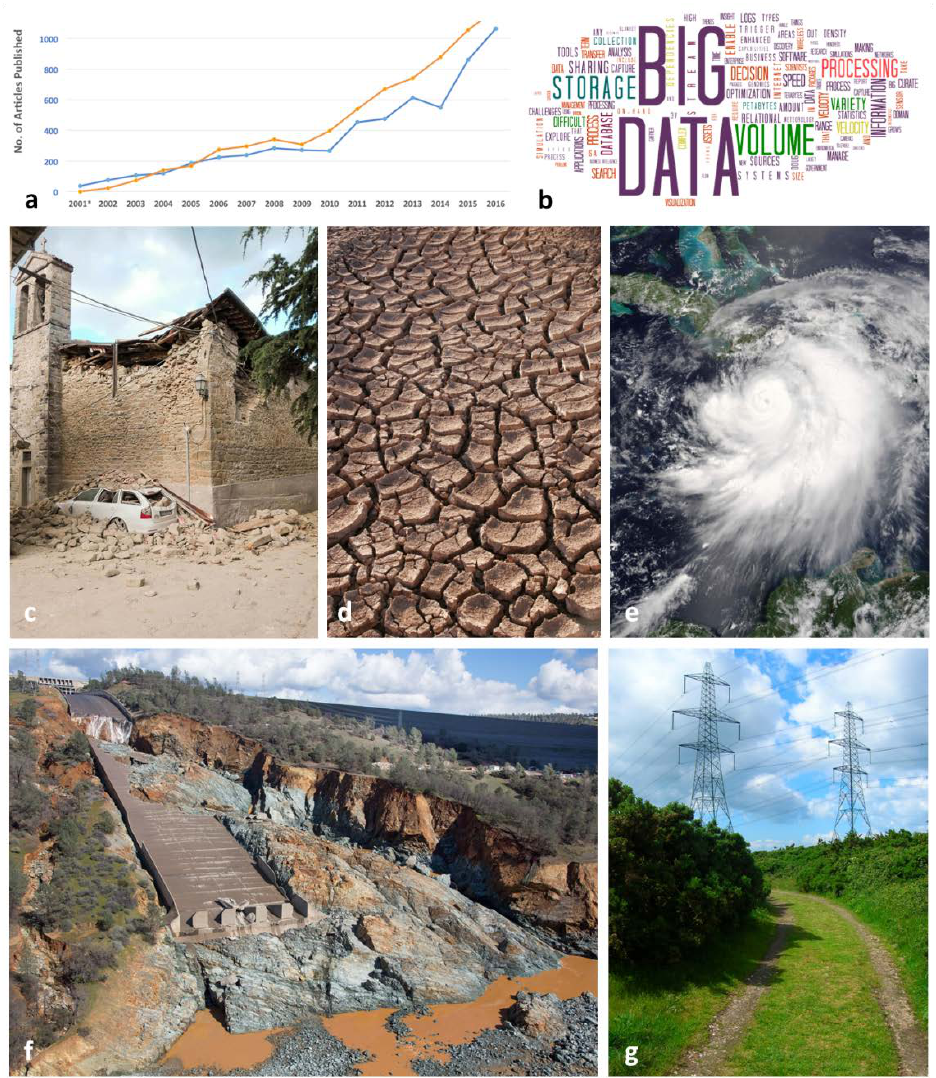
Figure 2. Natural hazards research topics covered by the papers published in the special issue: ( a ) trends in natural hazards research; ( b ) Big Data in natural disaster management; ( c ) earthquakes and seismic risk; ( d ) drought; ( e ) hurricanes; ( f ) analysis of disaster incidents (Oroville Dam spillway incident, California, USA, February 2017); ( g ) electricity utilities and infrastructure. Photo source: Wikimedia Commons.